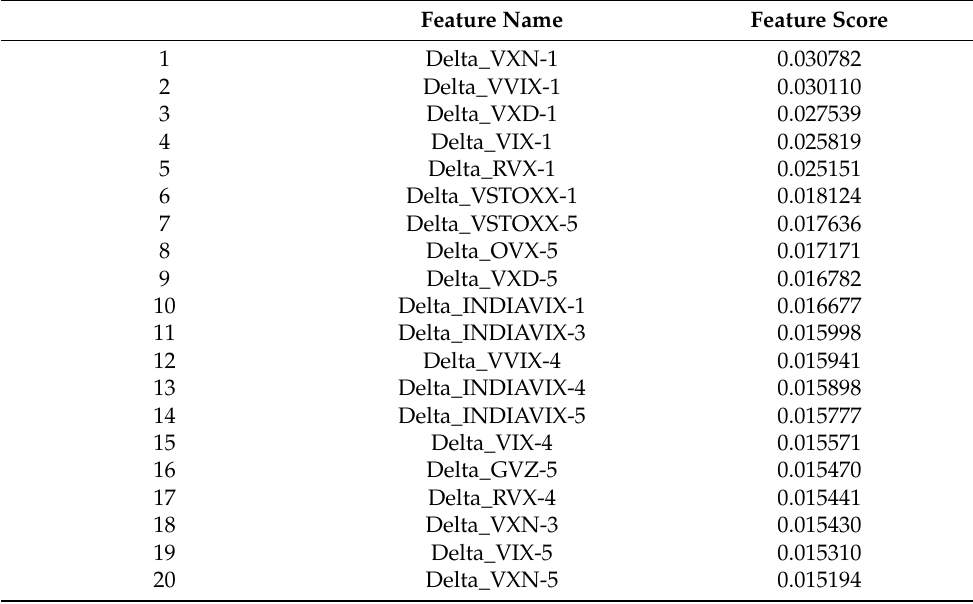
Figure 3. Plot of feature importance generated from logistic regression. Table 9. Top-twenty feature scores generated from XGBoost.